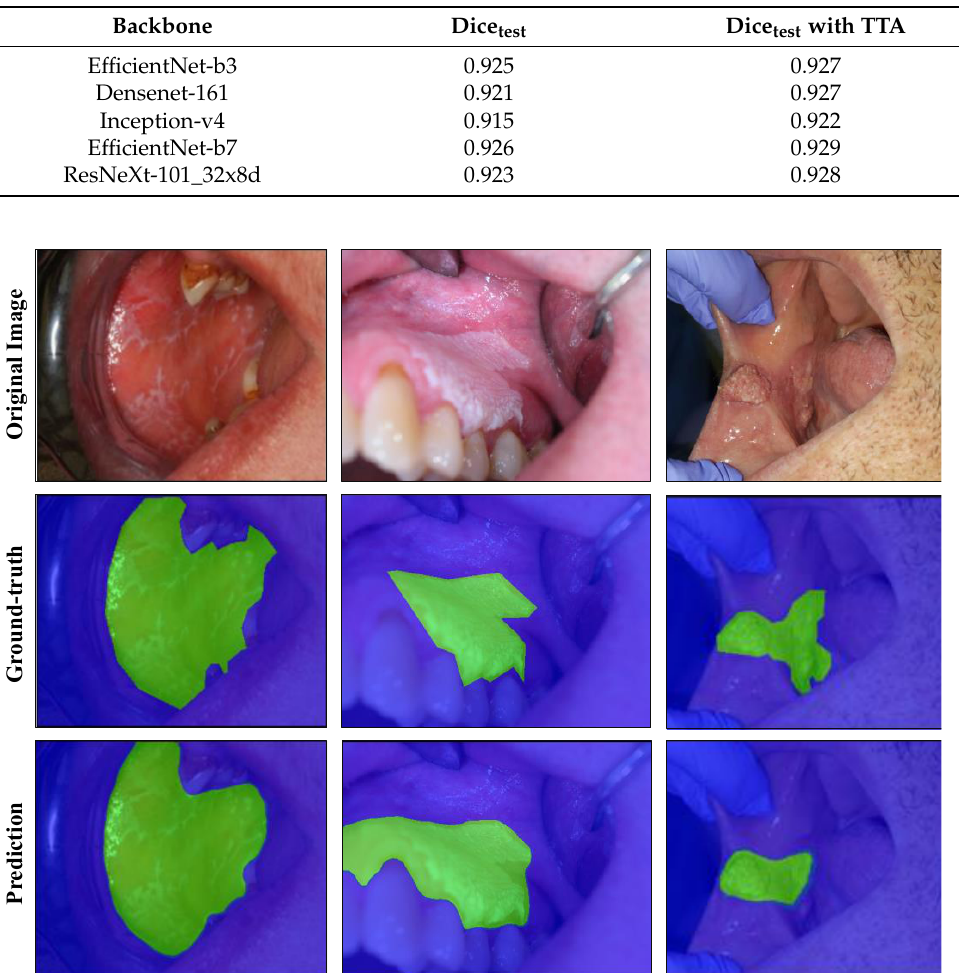
Figure 2. Semantic segmentation of oral lesions with EfficientNet-b7 model on test set. Each column is displaying a single test example with the original image in the top row, the ground-truth segmentation in the middle row, and the predicted segmentation in the bottom row. Lesion and background masks are shown in green and blue colours, respectively.